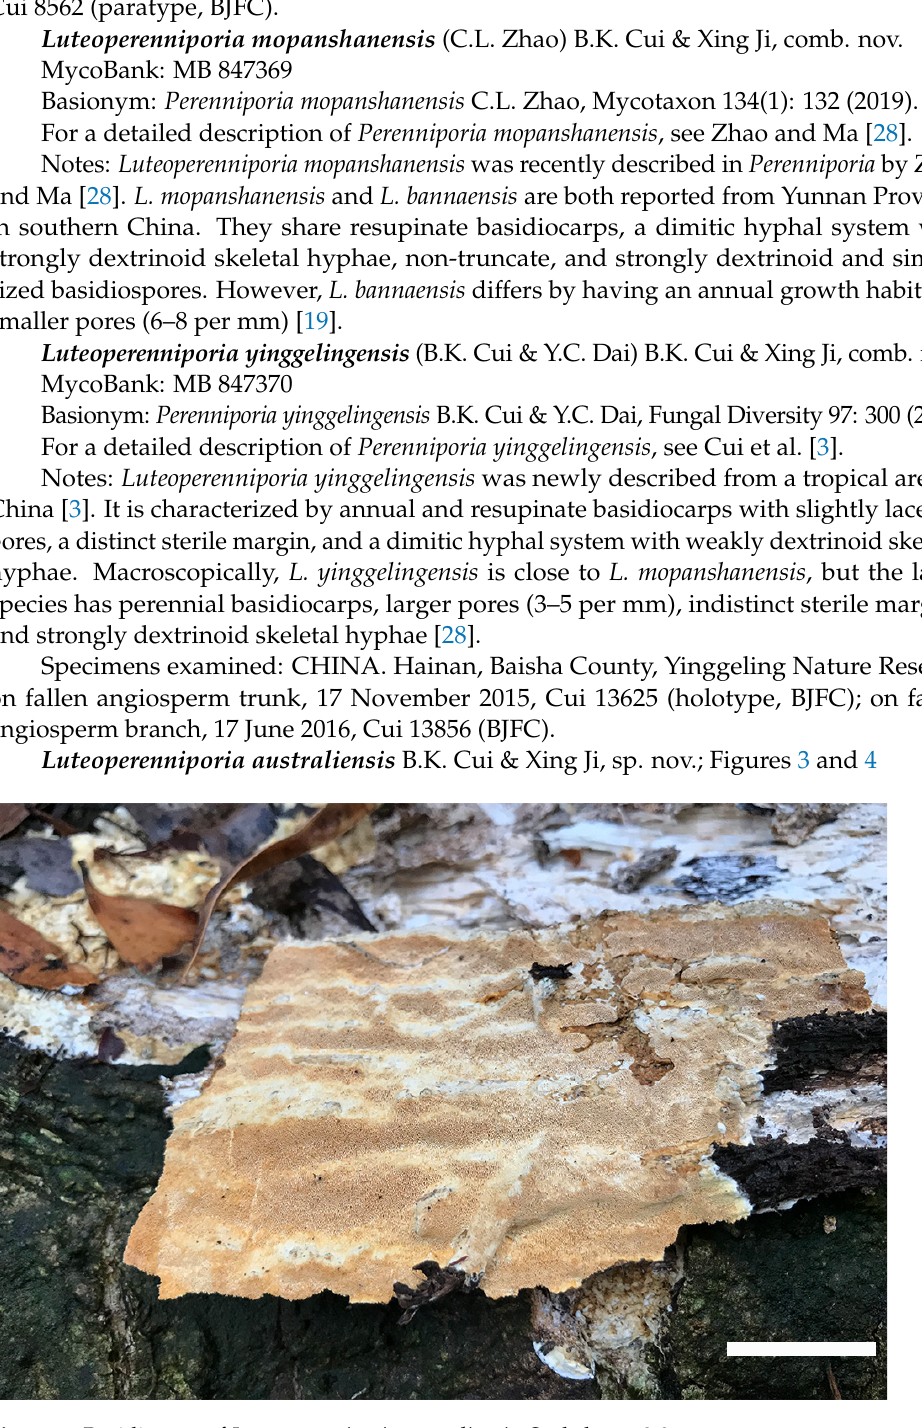
Figure 3. Basidiocarp of Luteoperenniporia australiensis . Scale bar = 2.0 cm.